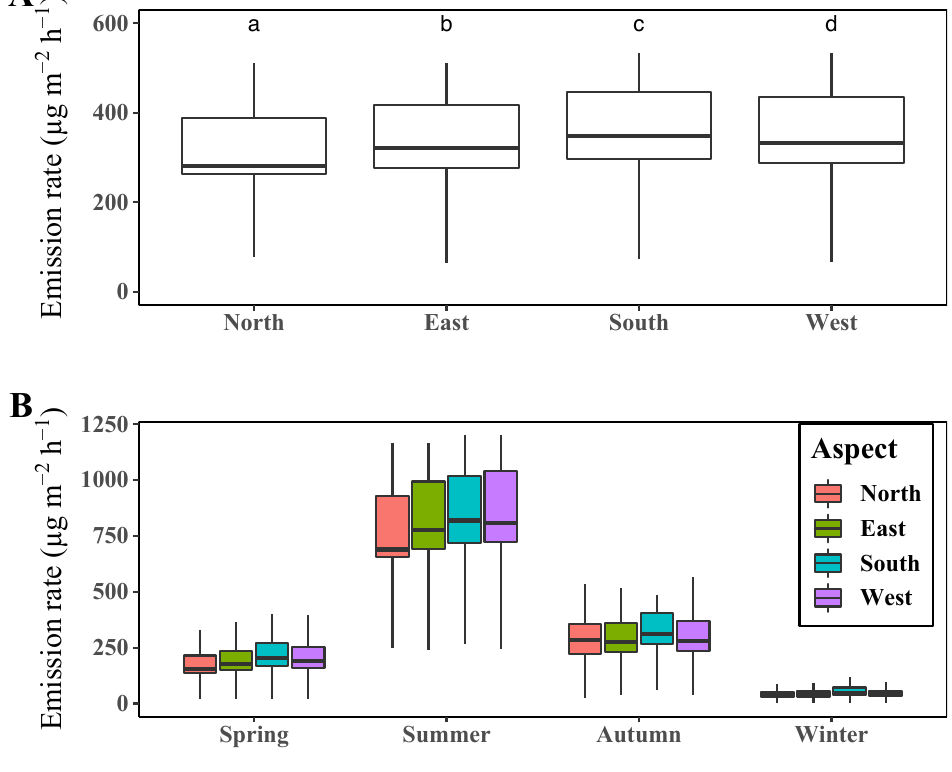
Figure 5. ( A ) Mean terpene emission rate by slope aspect during the whole year in 2020 and ( B ) for each season. Different letters above the boxplots in A indicate significant differences (Dunn’s test p < 0.05) among mean values of terpene emission